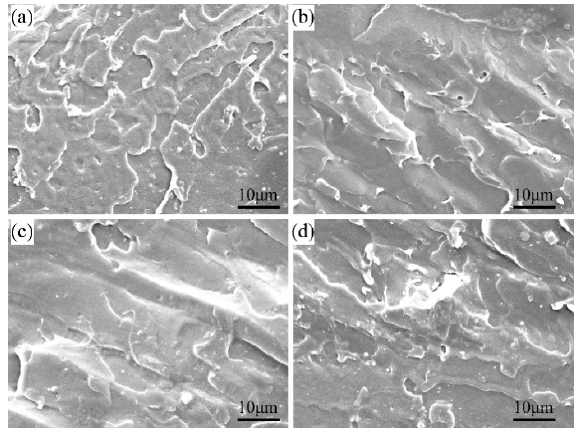
Figure 8. SEM images of ( a ) neat PLA, ( b ) GO0.25/PLA, ( c ) GO0.75/PLA, and ( d ) GO1.0/PLA.